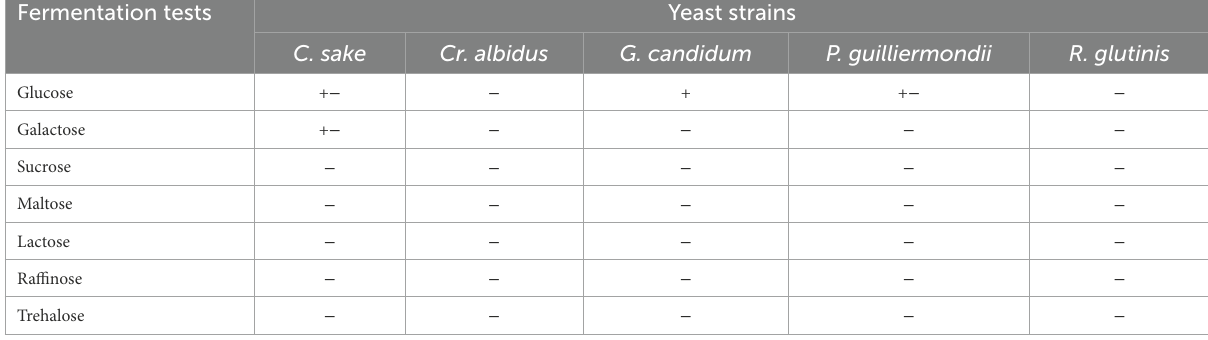
TABLE 6 Zymogram of yeast strains contaminating strawberry fruits from the two localities Loukkos and Gharb. Fermentation tests